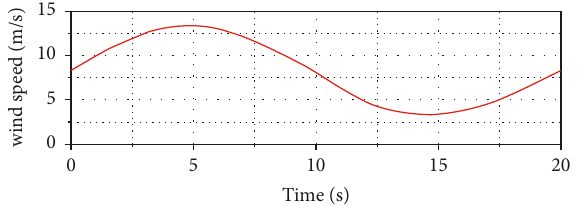
Figure 20: Wind speed profile.